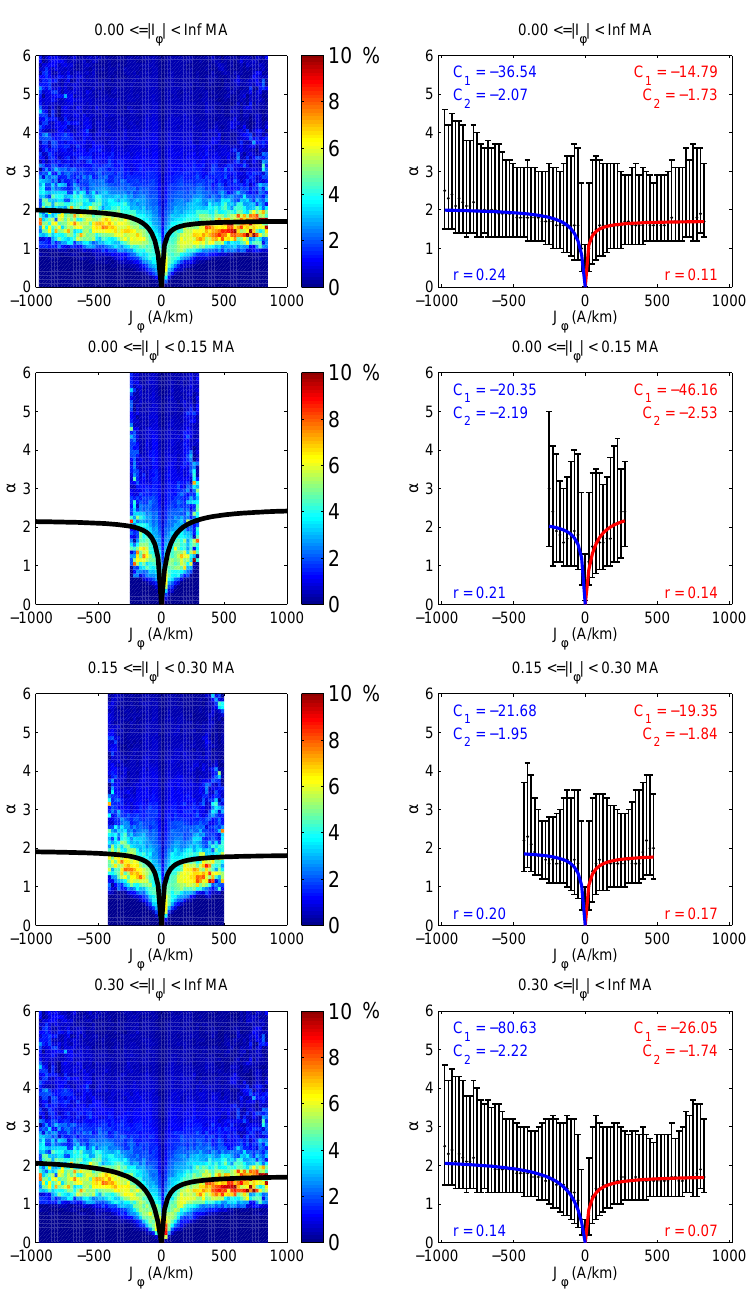
Fig. 13. Left: The probability for different values of α = − J φ /J θ as a function of J φ (summing up each column gives 100%). Columns with less than 500 data points are rejected (white). The resolution of the plots is 25 A / km in J φ and 0.1 in α . The different panels correspond to the different levels of activity: 0 ≤ | I φ | MA ( top ), 0 ≤ | I φ | < 0 . 15 MA ( second from top ), 0 . 15 ≤ | I φ | < 0 . 30 MA ( second from bottom ), 0 . 30 ≤ | I φ | MA ( bottom ). Right: The four panels on the right hand side column of the figure are arranged similar to those on the left hand side. The points represent the median, and the errorbars the 15.9 and 84.1 percentiles. Using the least-squares method, to the points is fitted the curve of Eq. (6). The resulting constants C 1 and C 2 are denoted in the plots along with the residual r of the fit.